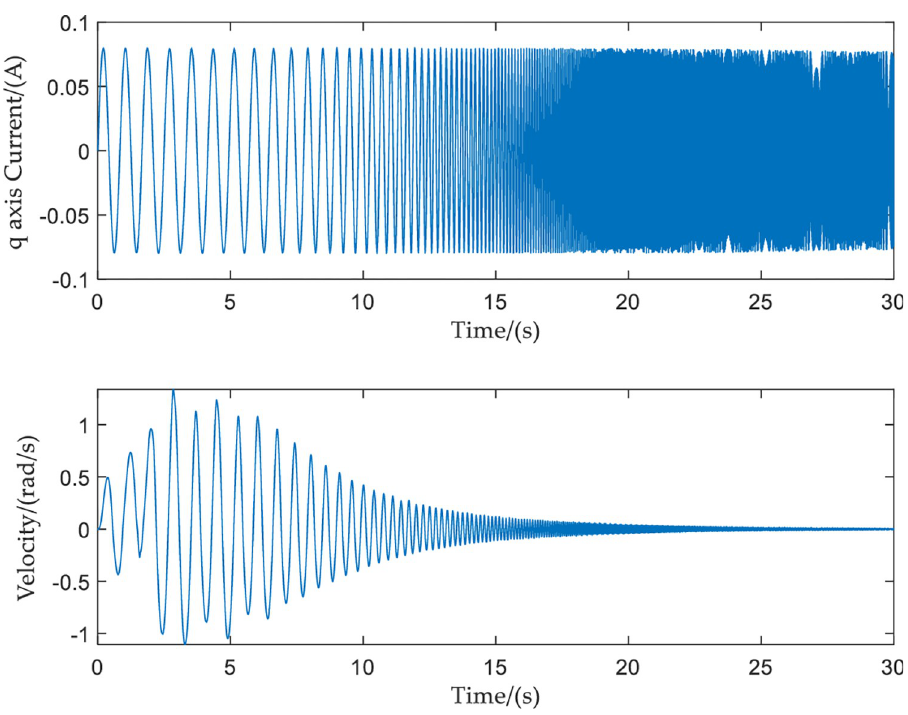
Fig 11. Sinusoidal frequency sweep signal input and output